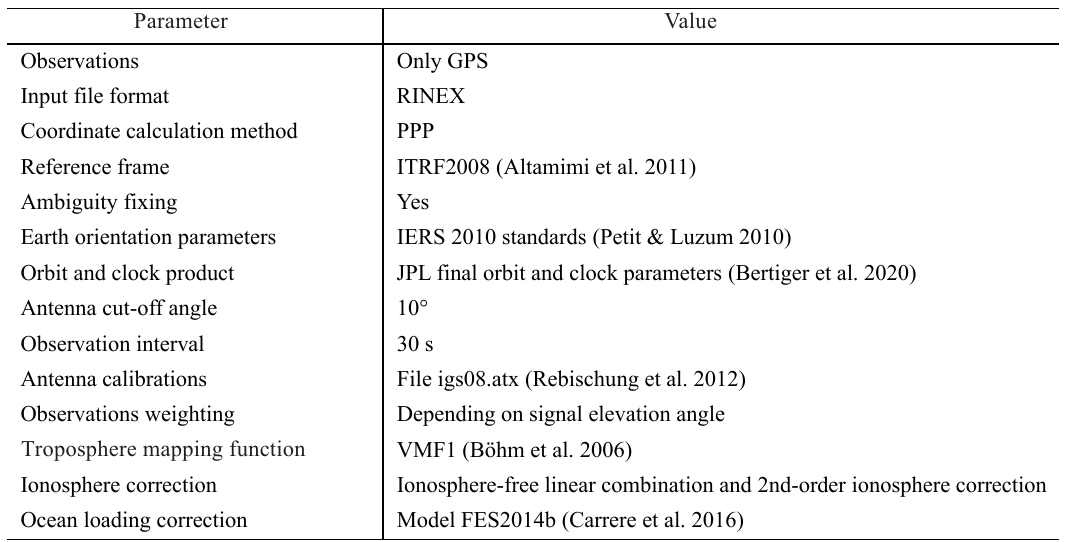
Table 2. Parameters used in coordinate calculation by Gipsy-Oasis II 6.4